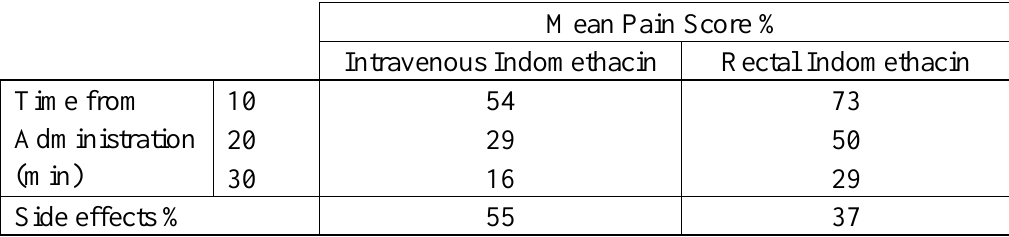
Table 1. The mean pain score (as a percentage of that before treatment) after 50 mg intravenous or 100 mg rectal indomethacin [18].